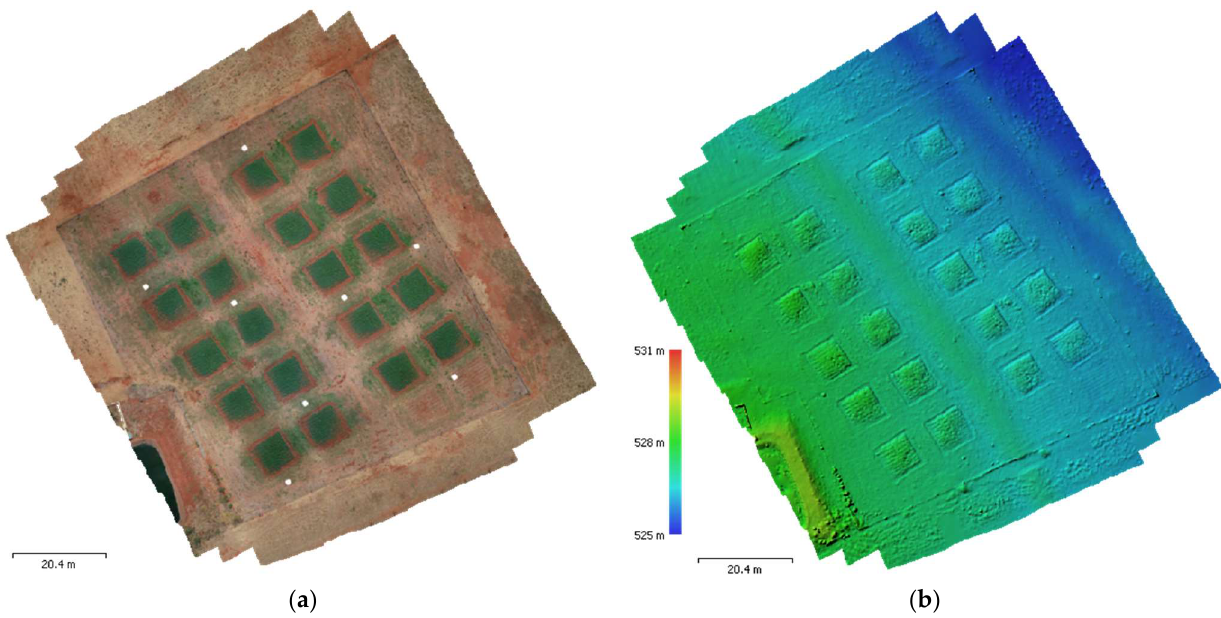
Figure 2. Photogrammetric products resulting from the flight performed on September 15. ( a ) Orthoimage. ( b ) Digital surface model. Table 2. Descriptive information from photogrammetric products.